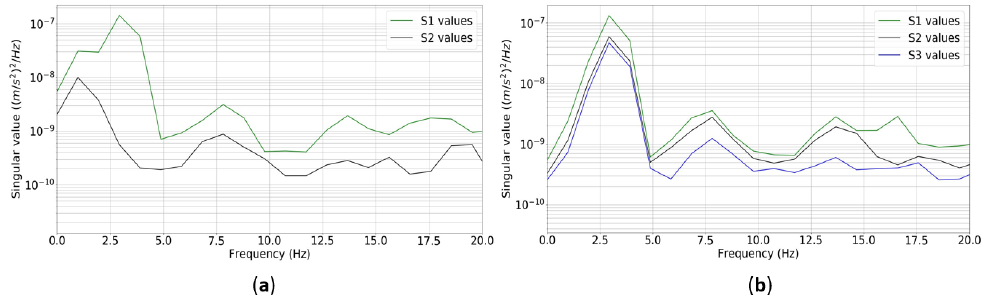
Figure 28. Transverse dynamic response of the 3-DOF structure in the frequency domain: ( a ) SVD spectrum of the reference SHM system. ( b ) SVD spectrum of the low-cost SHM system.